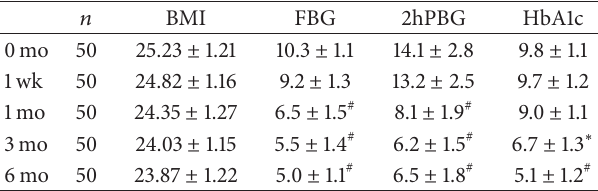
Table 1: Comparison of glucose metabolism index before and after the surgery.